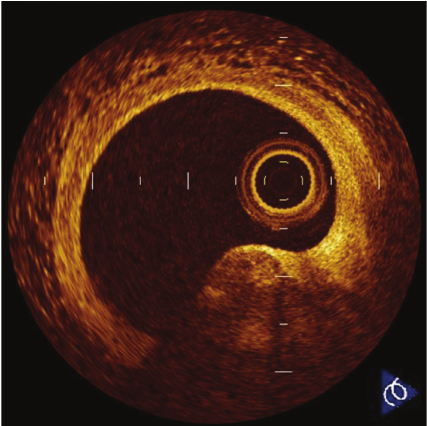
Figure 5: Calcified nodule. Calcified nodule is defined as a pro- trusion of a signal-poor or heterogeneous region with a sharply delineated border. The origin of this lesion is not precisely known, but it appears to be associated with healed plaques.